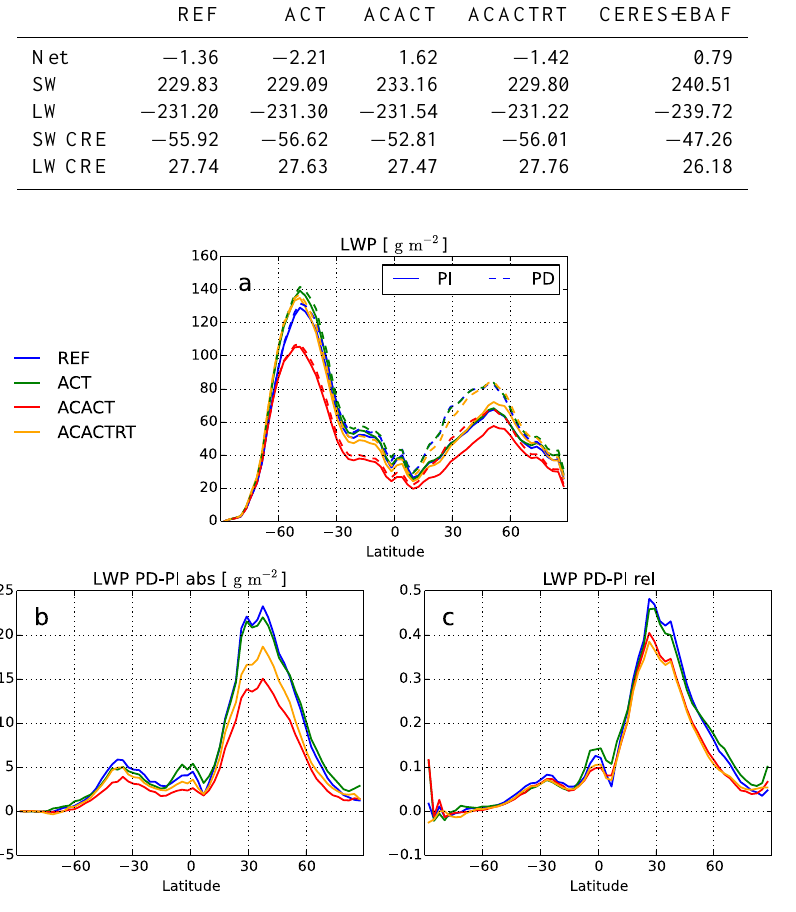
thropogenic aerosol increase, compared to a traditional mod- elling